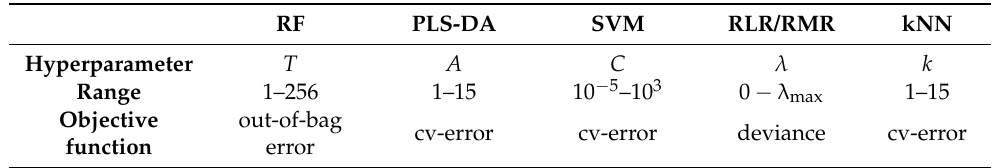
Table 5. Ranges for the hyperparameters of the classification learning algorithms and settings for the optimization using Genetic